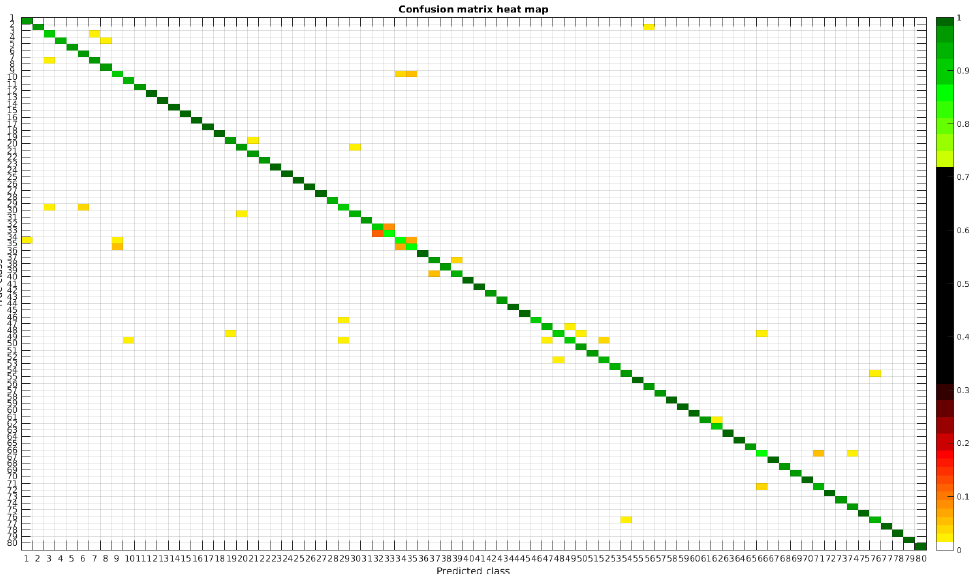
Figure 5. Confusion matrix heat map for the original dataset with 300 samples per